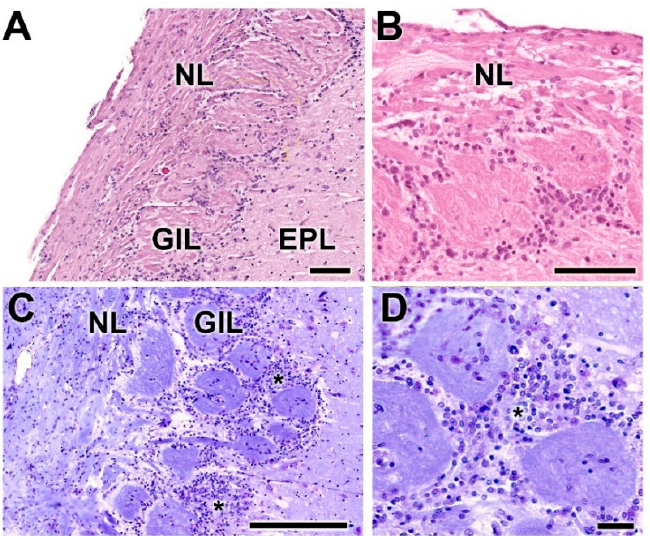
Figure 19. Histological study of the superficial layers of the olfactory bulb of the fox. ( A , B ) Hematoxylin–eosin staining of the nerve layer (NL), glomerular layer (GlL) and external plexiform layer (EPL). The asterisk indicates the presence of periglomerular cells. ( C,D ) Nissl staining. There is a high density of periglomerular cells in the border between the glomeruli and the EPL (asterisks). Scale bars: ( A , B , D ): 100 µm; ( C ): 250 µm.